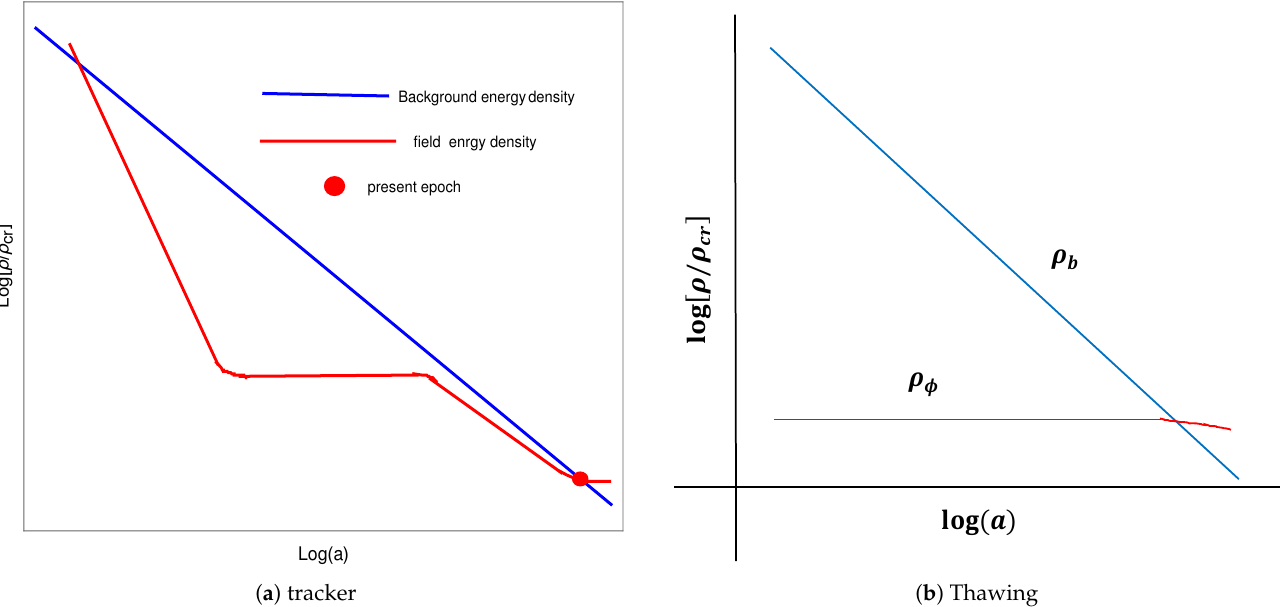
Figure 2. ( a ) shows evolution of field energy density ρ φ and background matter density (radia- tion/cold matter) versus ln ( a ) for a potential shallower than the exponential potential ( Γ > 1)—for instance, inverse power law potentials, V ∼ φ − n , n > 0 with Γ = 1 + 1/ n . After recovery from the freezing regime, the field on the steep part of the potential evolves with an equation of state parameter close to that of the background. In this case, the slope of the potential gradually decreases and the scalar field slowly moves towards the background and overtakes it and joins the slow roll with a diminishing value of the slope ˆa la a tracker . ( b ) shows schematic representation of thawing quintessence, where the field is frozen on a flat potential due to Hubble damping. When ρ φ ap- proaches the background energy density at late times, the field resumes slow roll and accounts for late time